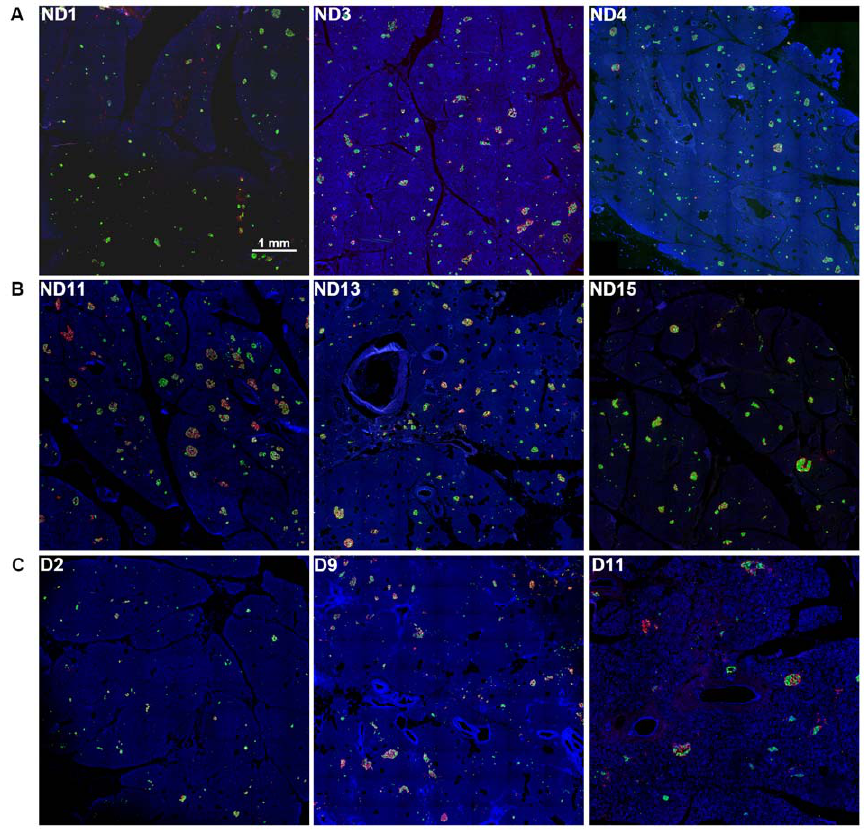
Figure 2. Representative pancreas images. A: Pancreatic sections immunostained for insulin (green), glucagon (red), somatostatin (white) and nuclei (blue) of relatively young and healthy subjects. ND1: 15-yr, ND3: 24-yr, and ND4: 41-yr. B: Non-diabetic and aged subjects. ND11: 63-yr, ND13: 73-yr, and ND15: 81-yr. C: Subjects with T2D. D2: 42-yr, D9: 72-yr, and D11: 75-yr.